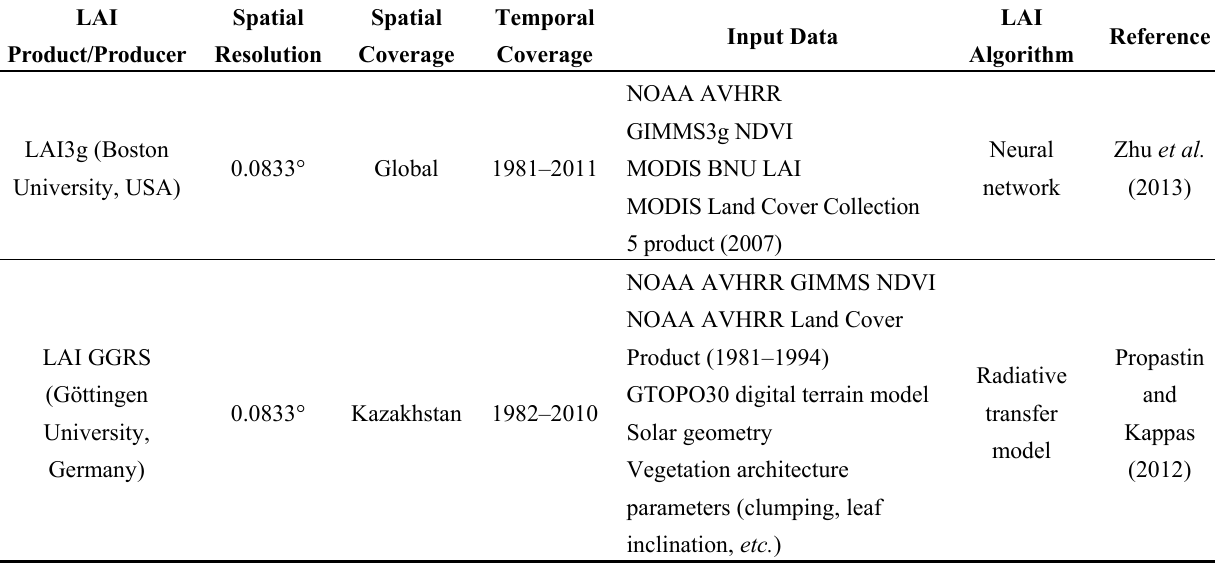
Table 1. Short description of the LAI products compared in this